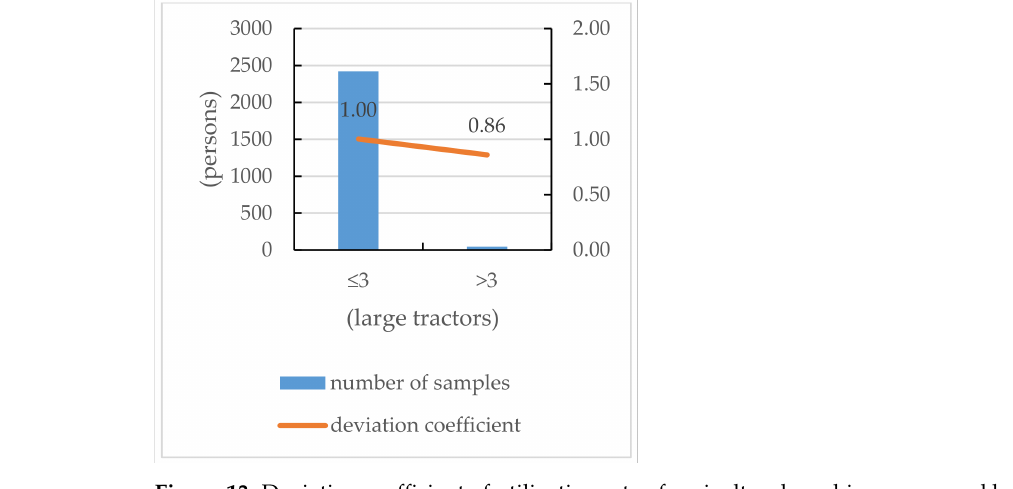
Figure 13. Deviation coefficient of utilization rate of agricultural machinery grouped by the number of large tractors.